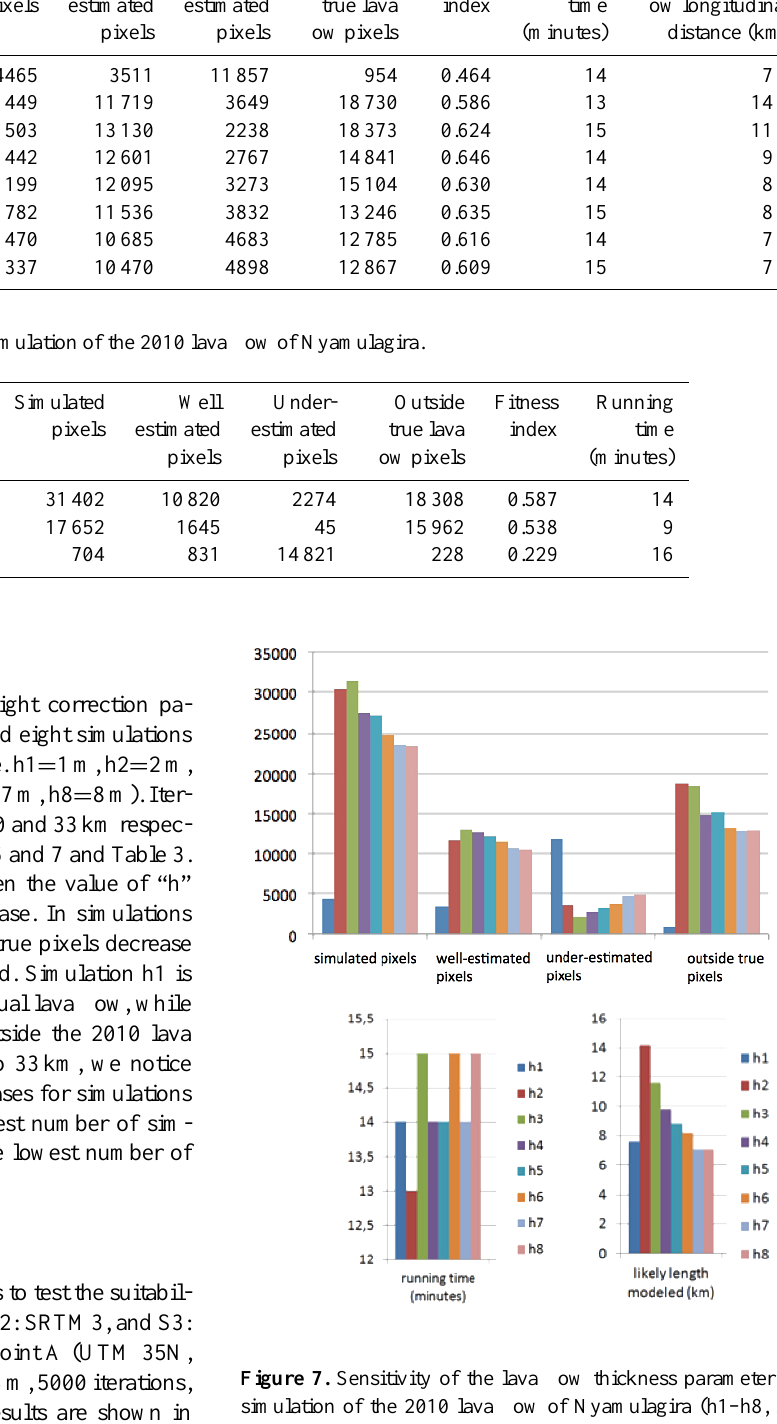
Table 3. Influence of lava flow average thickness on the simulation of the 2010 lava flow of Nyamulagira. Simulation (lava True lava Simulated Well Under- Outside Fitness Running Simulated lava flow average flow pixels pixels estimated estimated true lava index time flow longitudinal thickness in m) pixels pixels flow pixels (minutes) distance (km)